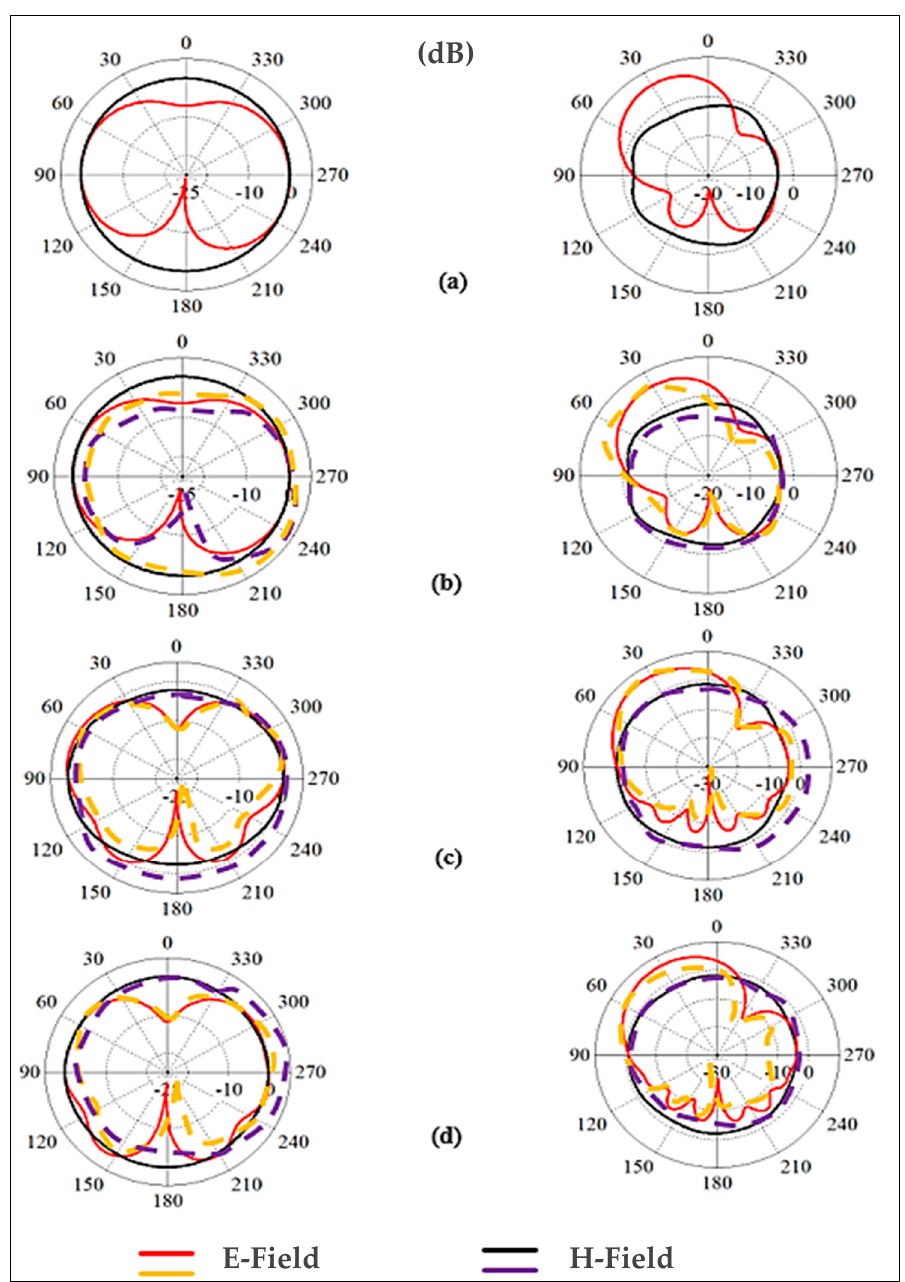
Figure 18. Simulated radiation patterns at 2.45 (left side) and 5.6 GHz (right side): ( a ) free space, no bending, ( b ) free space after bending, ( c ) bent on the layered chest, and ( d ) bent on the cylindrical arm. E field: yellow/red (normal/large sizes, left (2.45 band) and right sides (5.6 GHz), and H-field: black/purple) (normal/large sizes, left (2.45 GHz) and right sides (5.6 GHz).